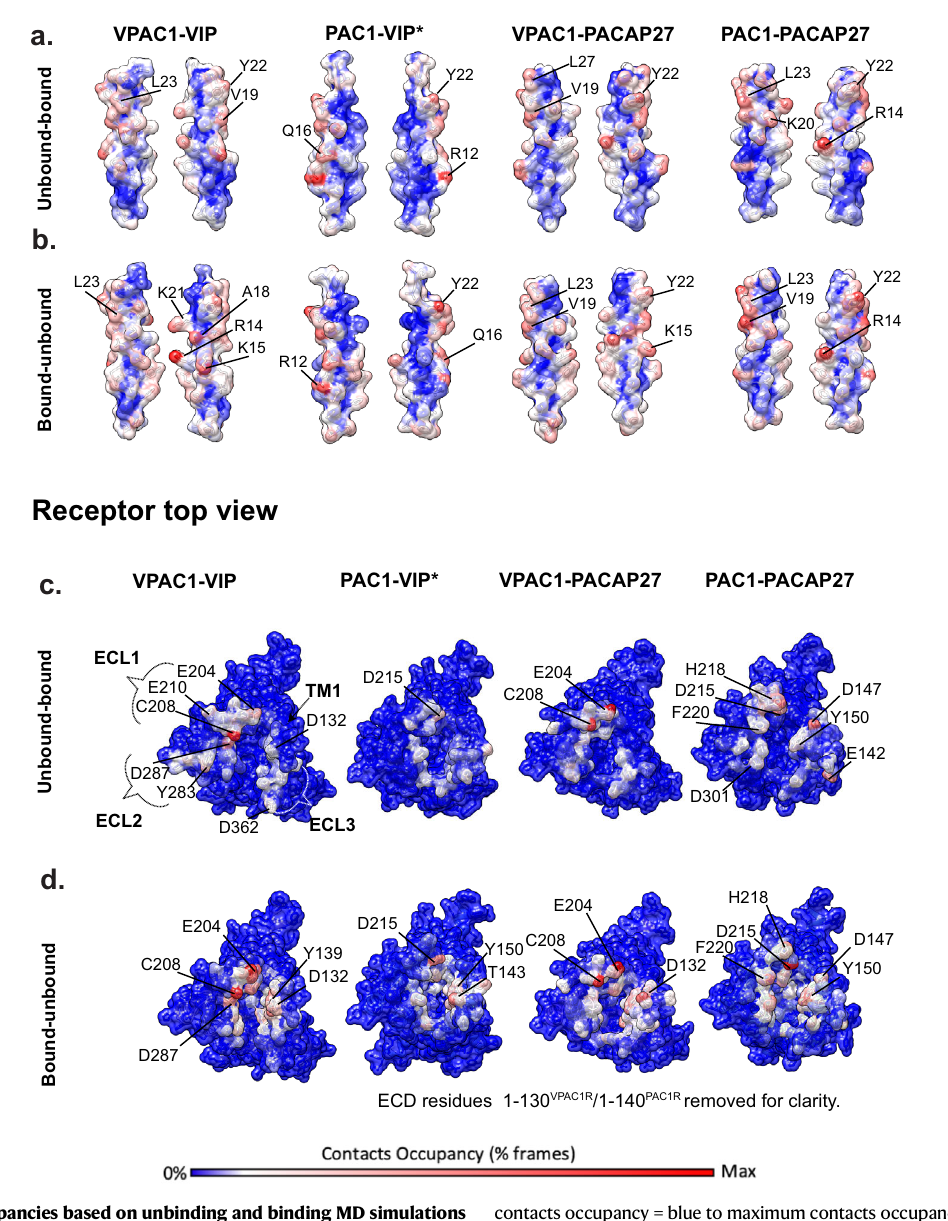
Fig. 4 | Contact occupancies based on unbinding and binding MD simulations comparing contacts between VIP and PACAP27, and PAC1R and VPAC1R. MD simulationswereperformedontheexperimentalPAC1R-PACAP27,VPAC1R-VIPand VPAC1R-PACAP27complexesandthePAC1R-VIP(homologymodel,asindicatedby asterisk *). The total occupancy (% MD frames) for each atom is plotted on the surfaceofthe peptide ( a , b ) or receptor( c , d )according to acolourscalefrom